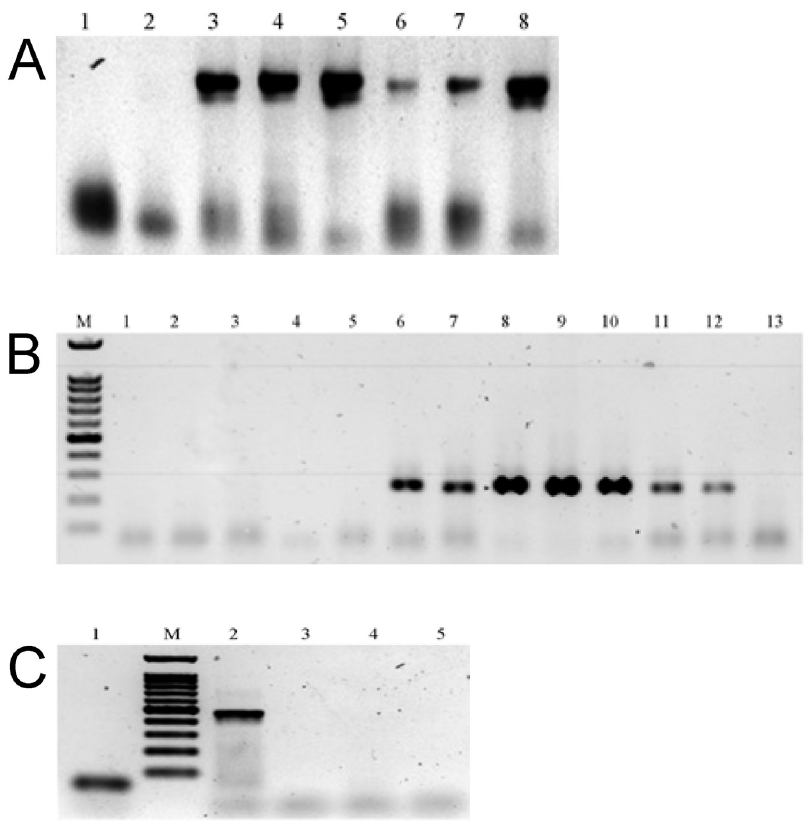
Fig 5. Detection of parasites’ DNA in Taraxacum officinale samples. ( A ) Helminth Test, 1—H 2 O, 2—dried dandelion leaves (Rudenka), 3— Oxyuridae sp. (eggs), 4— Echinococcus sp. (adult), 5— Taenia sp. (eggs), 6—